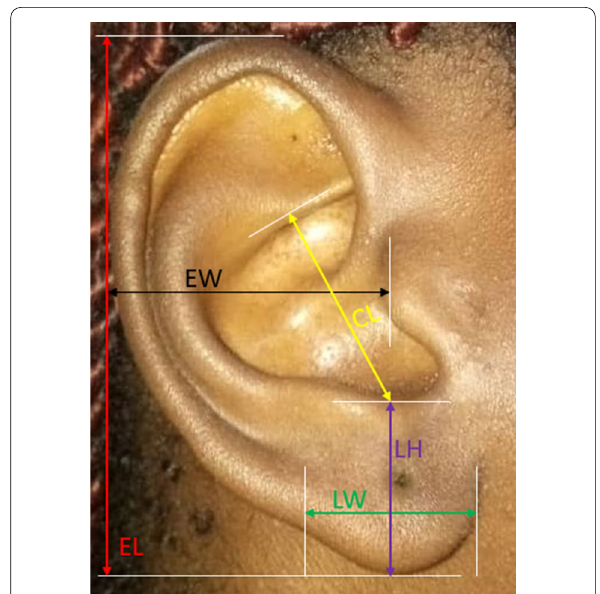
Fig. 2 Measured ear landmarks depicted with coloured arrows: ear length (red), ear width (black), lobule height (purple), lobule width (green) and concha length (yellow)